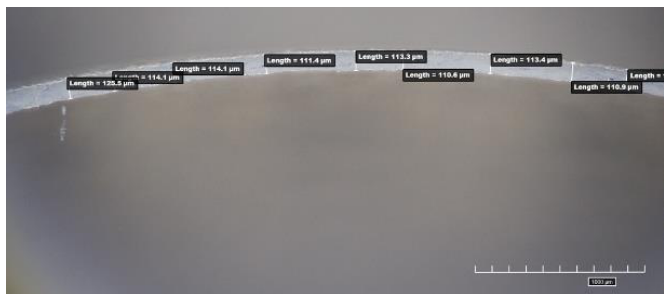
Figure 9: The uncoated sheet as measured by the Hirox digital microscope